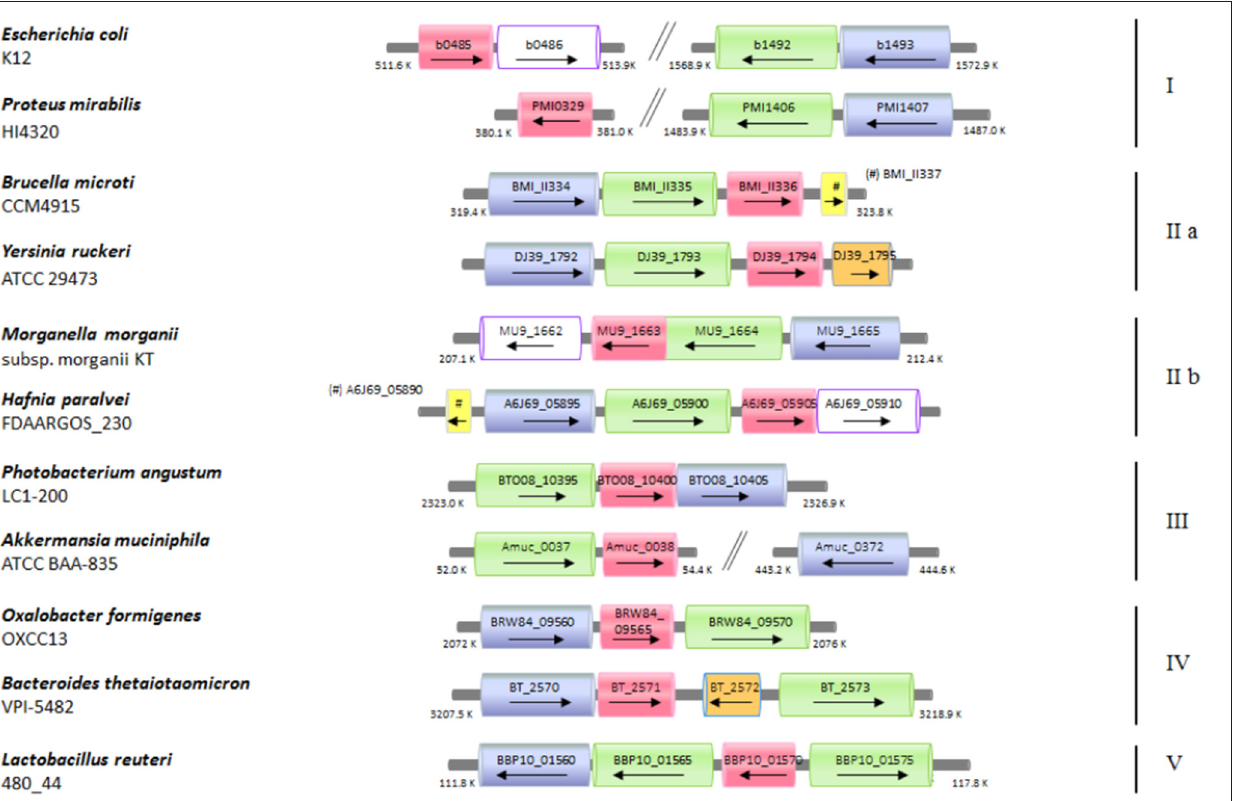
FIGURE 5 | Schematic representation of the distribution of the genes coding for ybaS / glsA , gadB , and gadC in different bacterial genomes. Selected bacterial species and strains, where a potentially functional AR2_Q system occurs, are shown. The arrow lengths and the relative distances are proportional to the gene lengths and distances between adjacent genes, respectively. The corresponding locus tags are shown within each arrow. The homologous genes are represented in different colors: ybaS/glsA , in magenta; gadC , in green; gadB , in blu; ybaT , in white with violet contour; hdeA/B (periplasmic chaperone) in yellow; putative potassium channel, in orange. The genes with putative functions are dashed in the same color as that of the genes with an assigned function.